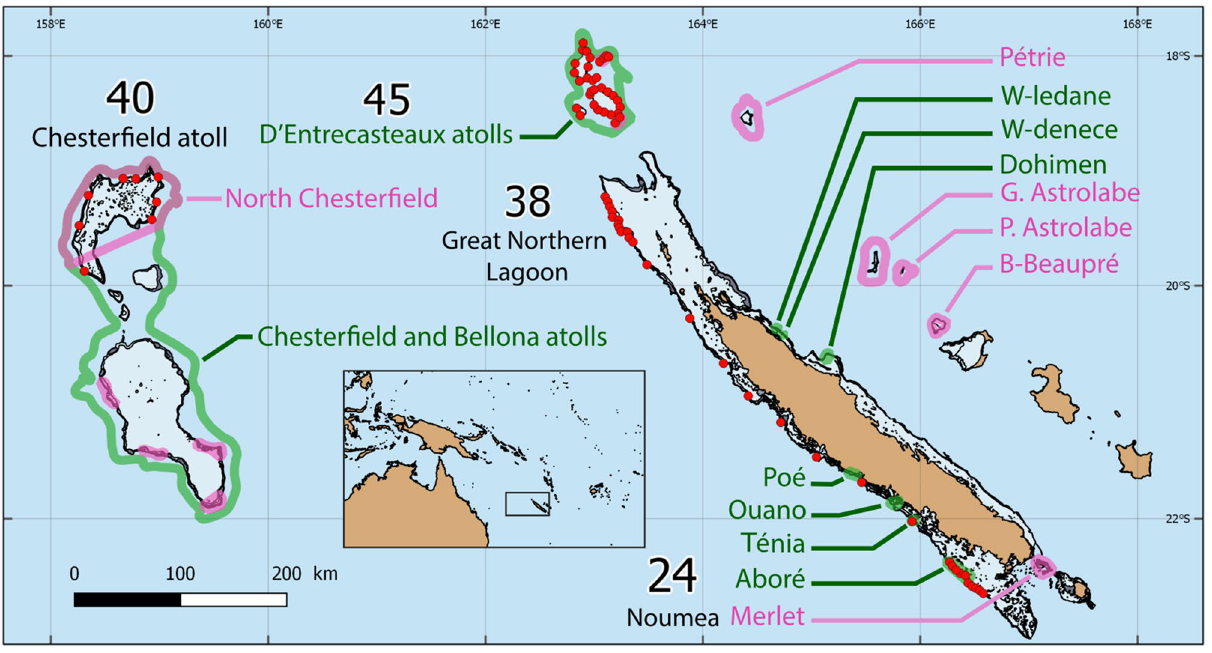
Figure 1. Acoustic array, marine protected areas and shark sampling in the New Caledonian archipelago, South-Western Pacific. Red circles indicate acoustic receivers. The number of sharks sampled in the four study regions are displayed. Green contours represent no-take MPAs and pink contours represent no-entry MPAs. Map generated with QGIS Version 3.2 (https:// www. qgis. org/) and shapefile data from 43